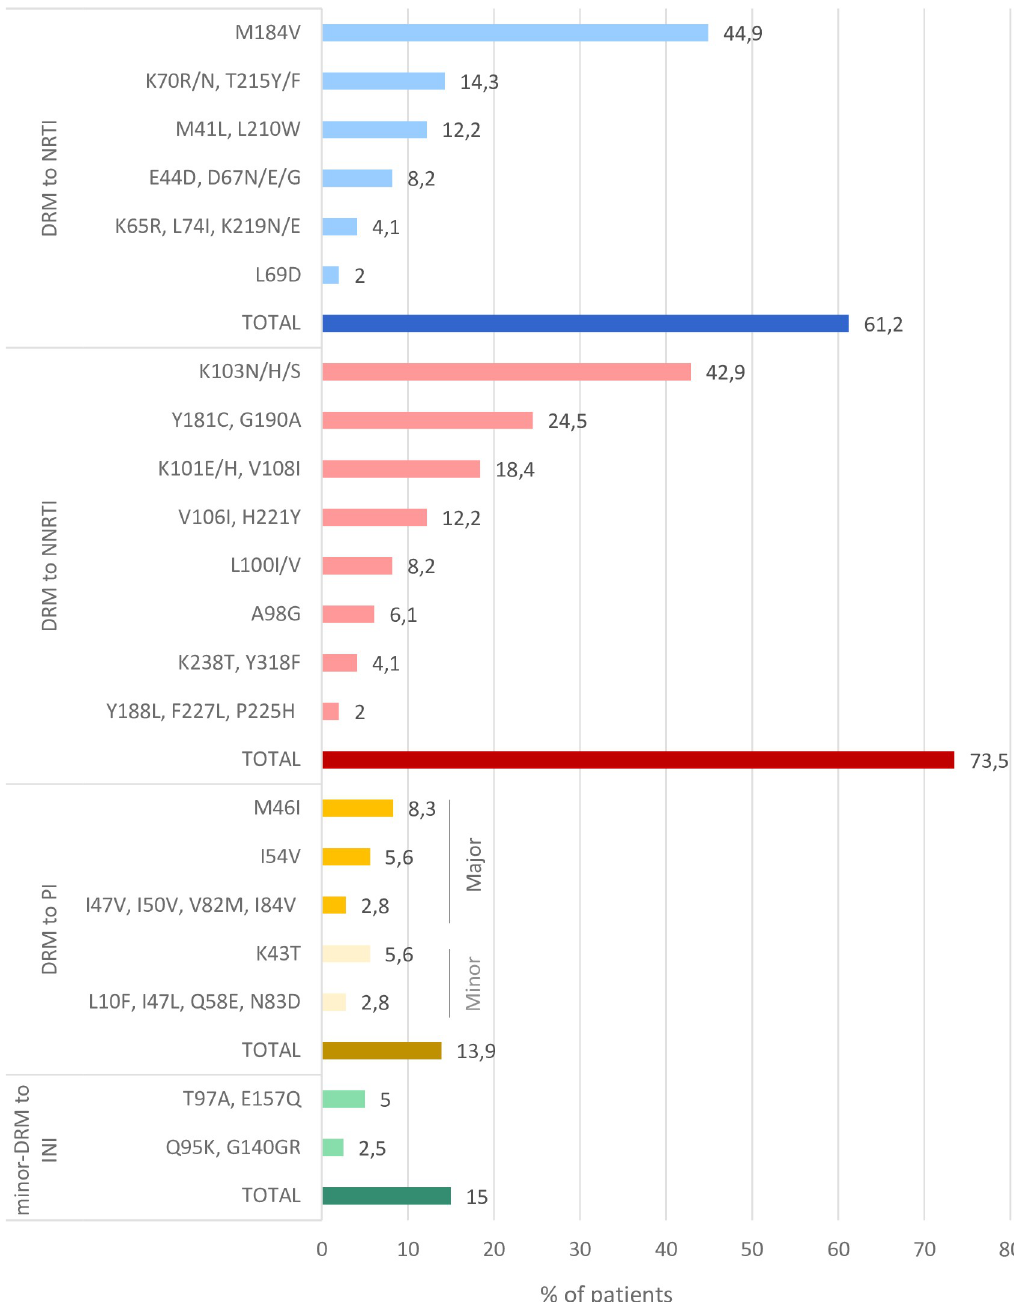
Fig 2. Drug resistance mutations to the main antiretroviral families in the study population. DRM, drug resistance mutation; NRTI, nucleoside transcriptase reverse inhibitor; NNRTI, non-NRTI; PI, Protease inhibitor; INI, integrase inhibitor. Available sequences in 55 children/adolescents under study: 38PR, 49RT, and 40IN. More data available in S2 Table